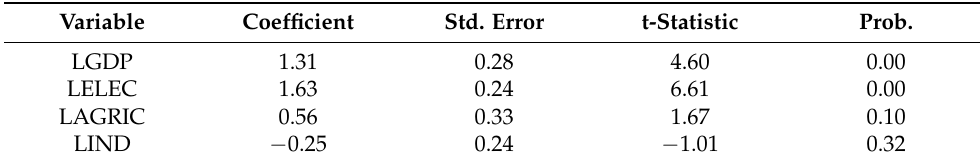
Table 4. Long-run relationship and coefficients towards CO 2 .